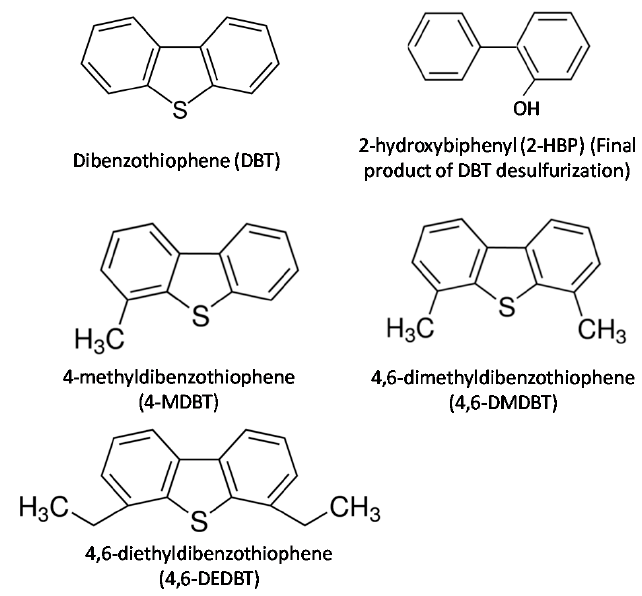
Figure 2. Chemical structure of different OSCs.